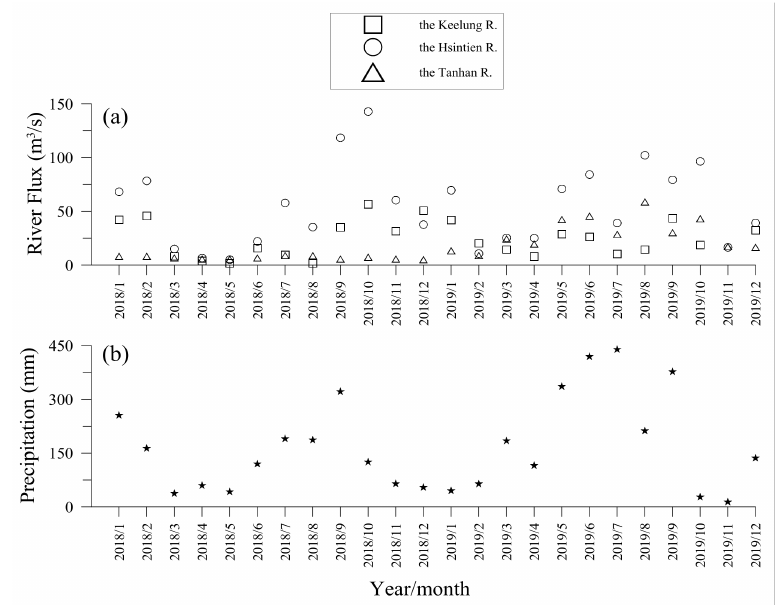
Figure 2. ( a ) The monthly average river fluxes of the three main tributaries of the DRE, and ( b ) the monthly average precipitation in the catchment area of the DRE during the periods